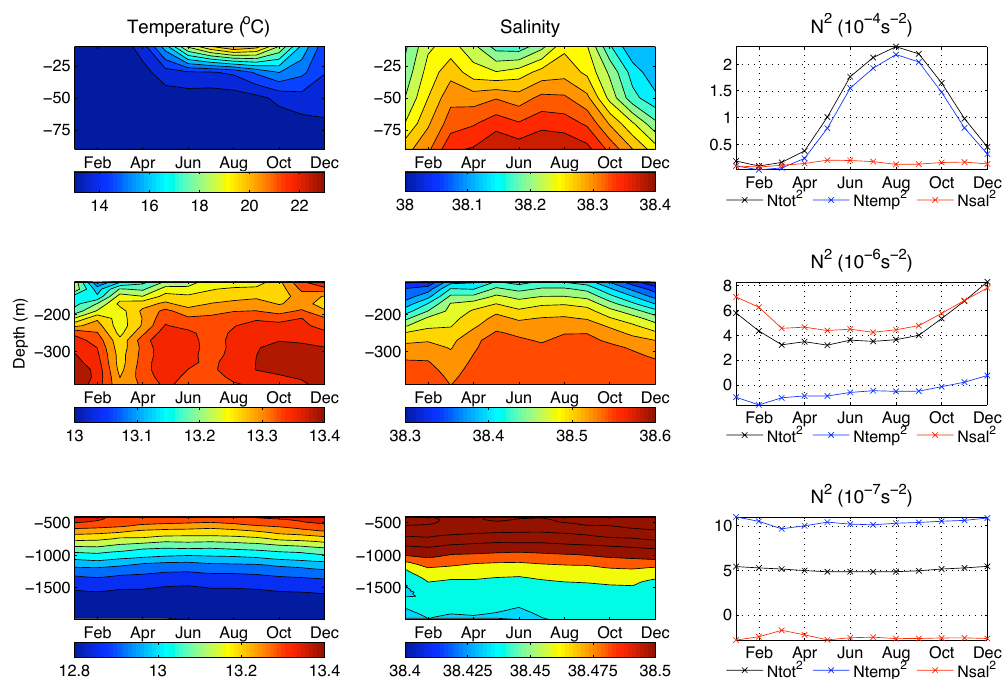
Fig. 3. Temperature (left), salinity (centre) and mean vertical buoyancy gradient (right - see text for definition of N 2 for the top (0-100m), intermediate (100-400m) and deep (below 400m) layers, over time (months) on the horizontal and depth (m) on the vertical, for the Dyfamed data.